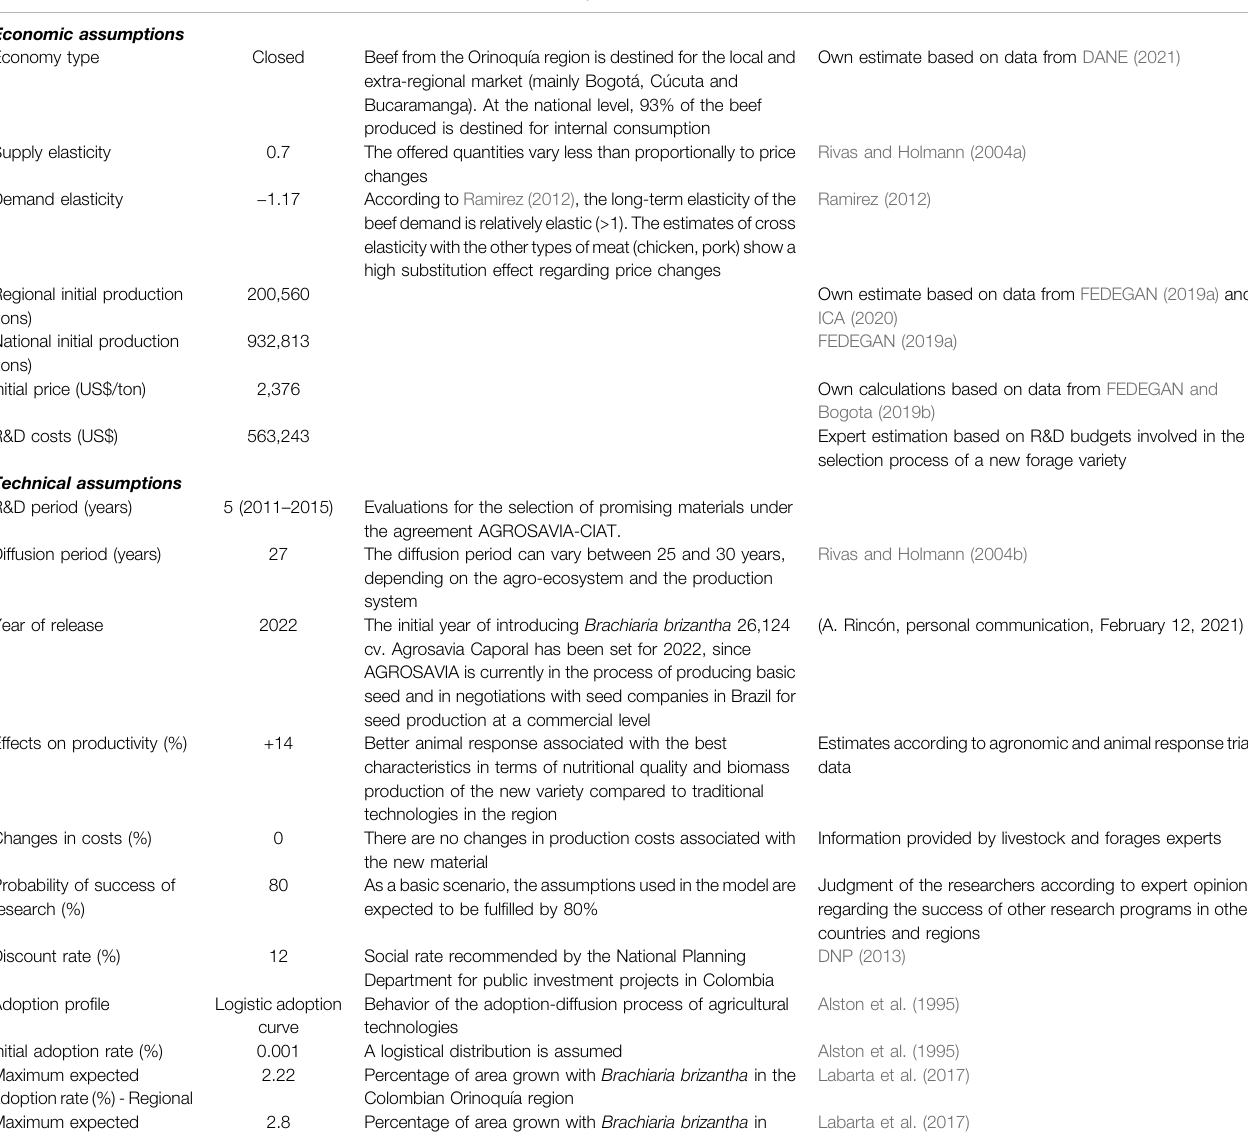
TABLE 3 | Description of the key parameters and data sources for the analysis of economic surpluses in the basic scenario.